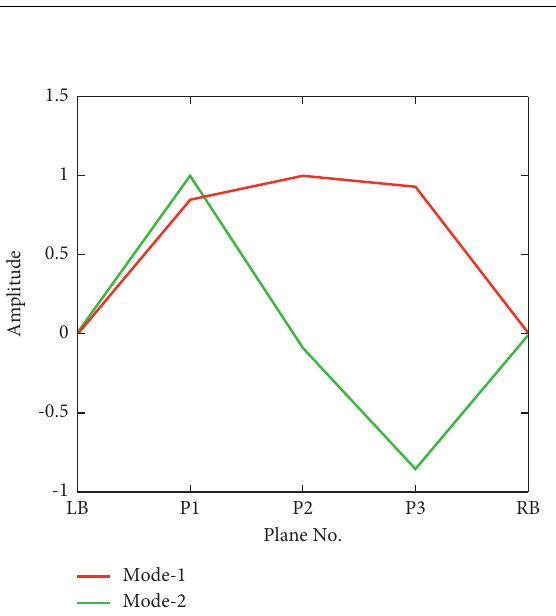
Figure 9: Mode shapes of the rotor. Table 3: Sensitivity matrix for mass changes in the three planes.